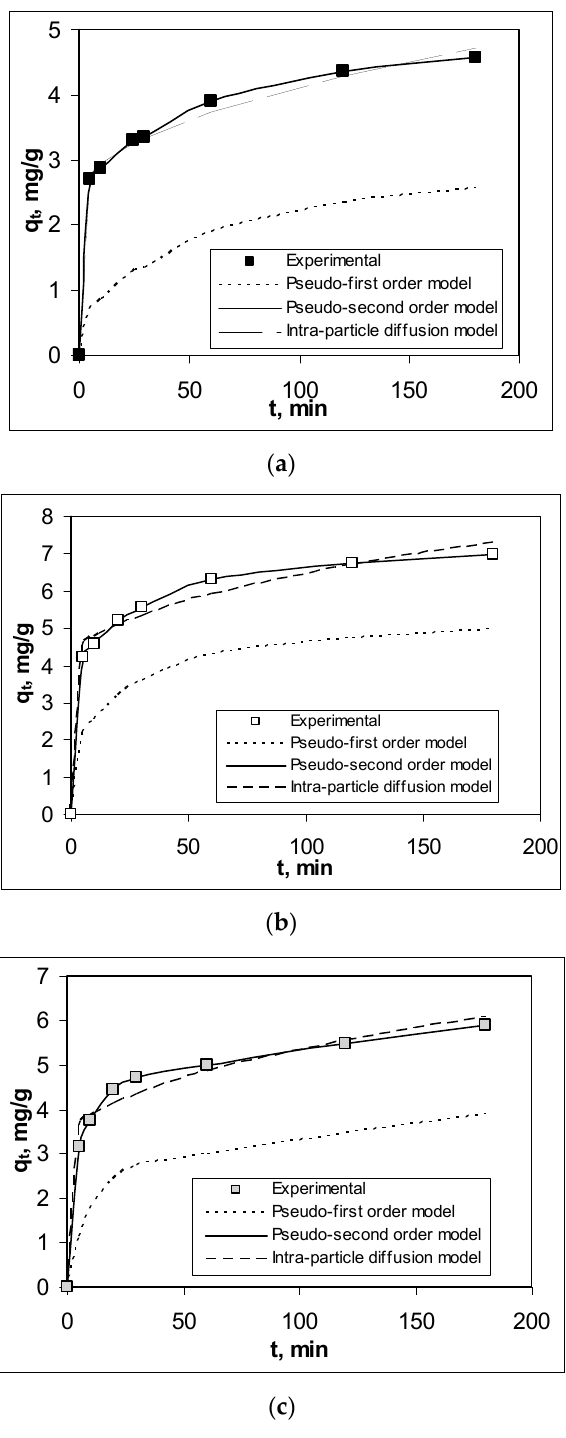
Figure 6. Kinetics modeling of Co(II) ions sorption on ( a ): ABC, ( b ): MBC, and ( c ) SBC (Experimental conditions: Initial pH = 5.0; 8.0 g biochar/L; c 0 = 48 mg Co(II)/L; 25 °C). Table 3. Kinetics parameters for the sorption of Co(II) ions on the three types of biochars.